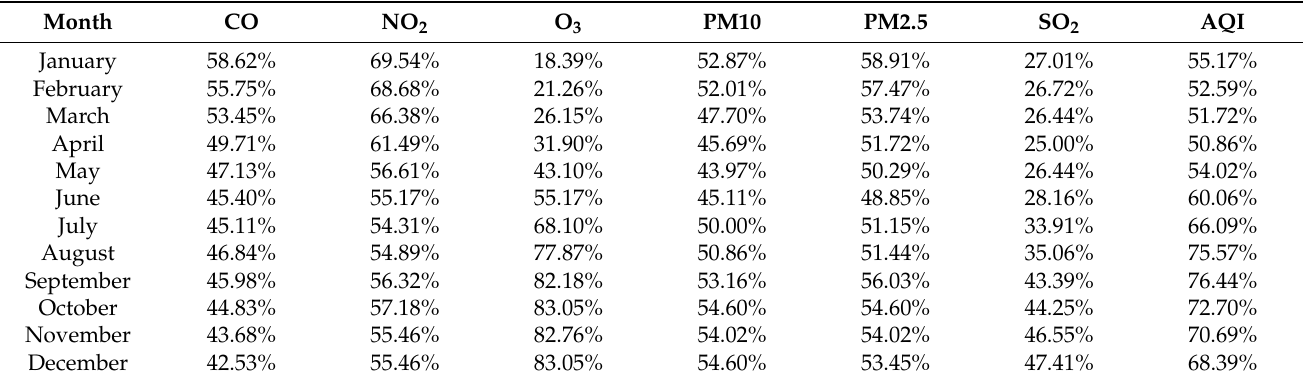
Table 3. The percentages of cities with improved air quality for different